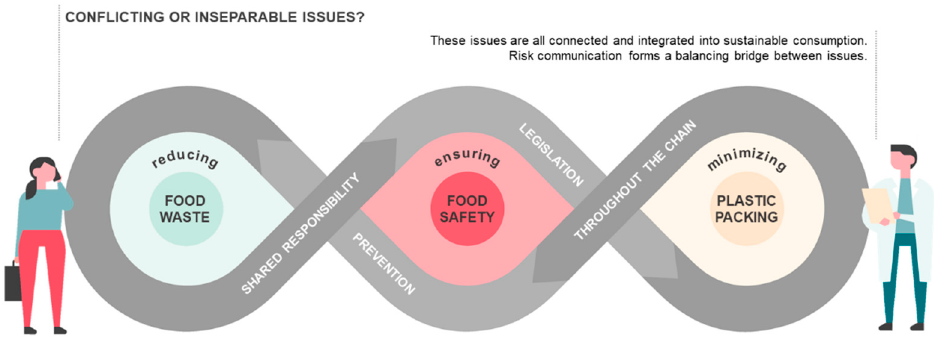
Figure 1. Connections between ensuring food safety, reducing food waste, and minimizing usage of plastic packaging (edited by the authors).